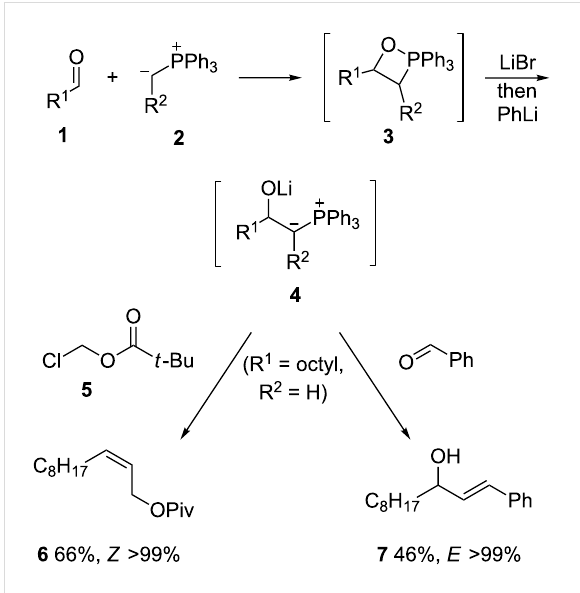
Scheme 1: Typical generation of ylide 4 and reaction